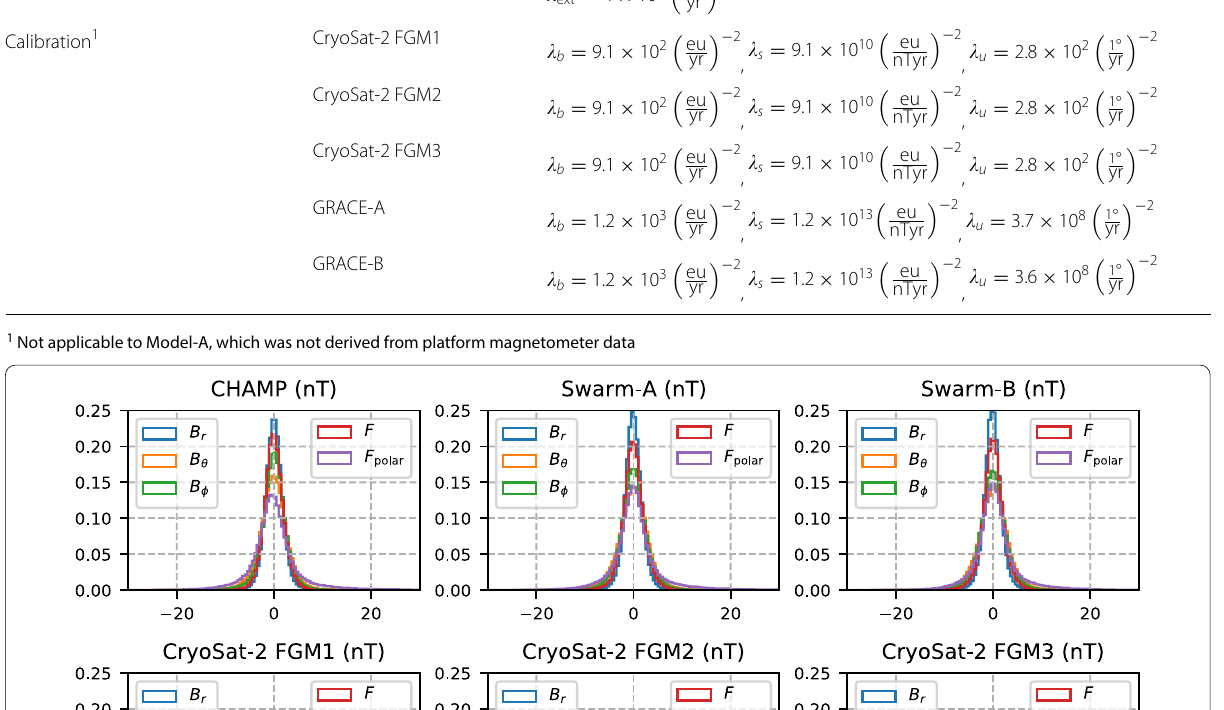
Table 4 Chosen numerical values of the regularization parameters. The values are valid for all the models built in this paper insofar as the regularization terms are applicable to the specific model Description of the model parameters